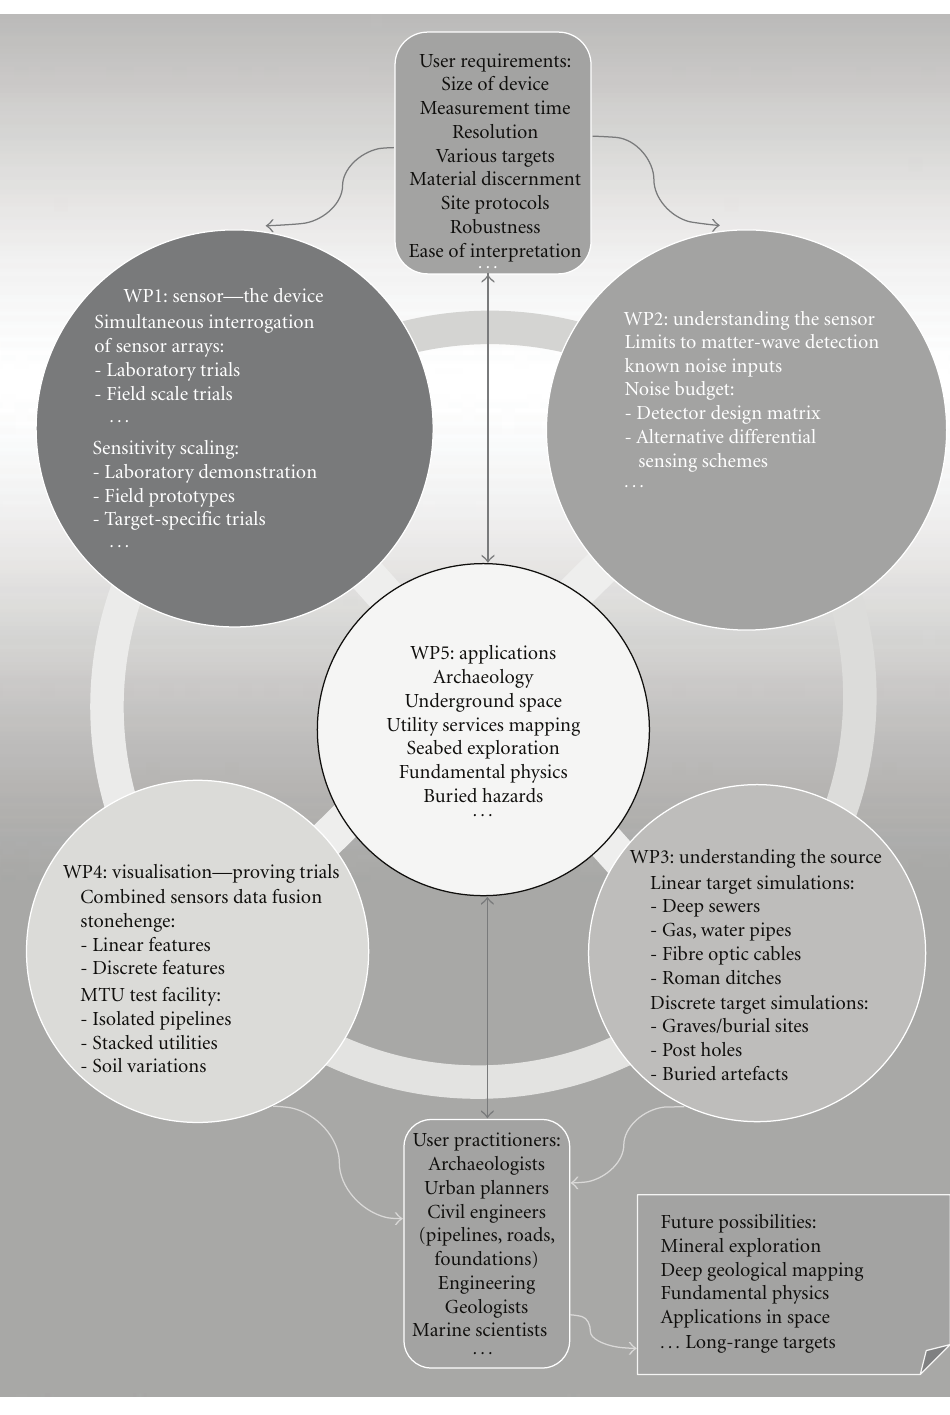
Figure 3: Schematic of the GG-TOP project, the interaction between the di ff erent work packages, and the potential applications.